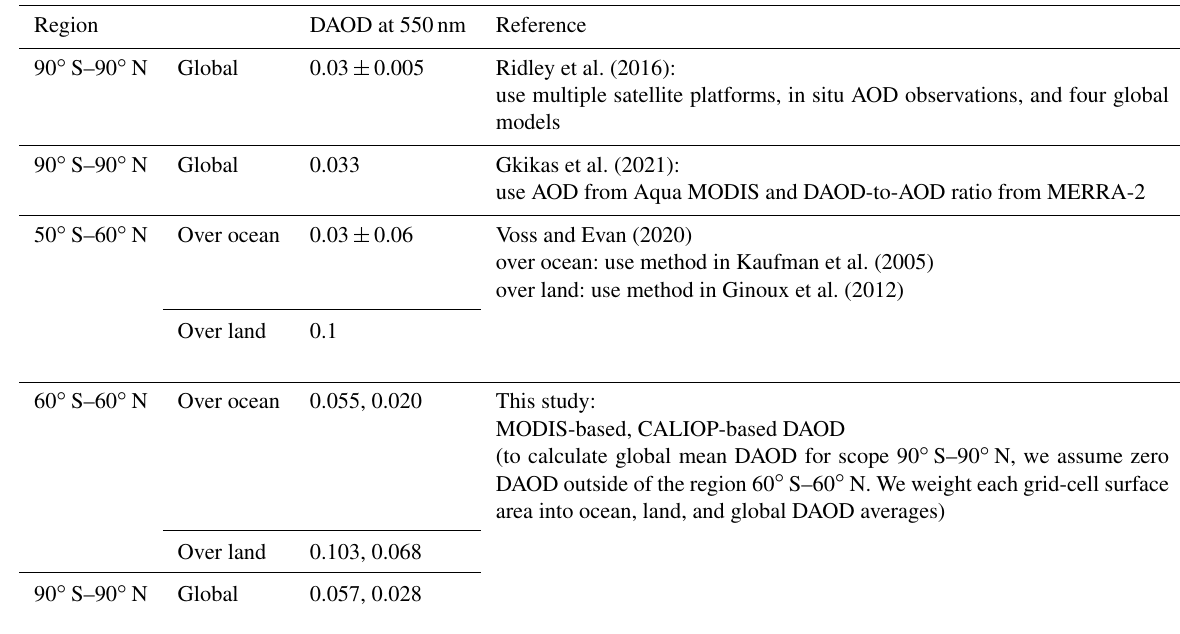
This study: MODIS-based, CALIOP-based DAOD (to calculate global mean DAOD for scope 90 ◦ S–90 ◦ N, we assume zero DAOD outside of the region 60 ◦ S–60 ◦ N. We weight each grid-cell surface area into ocean, land, and global DAOD